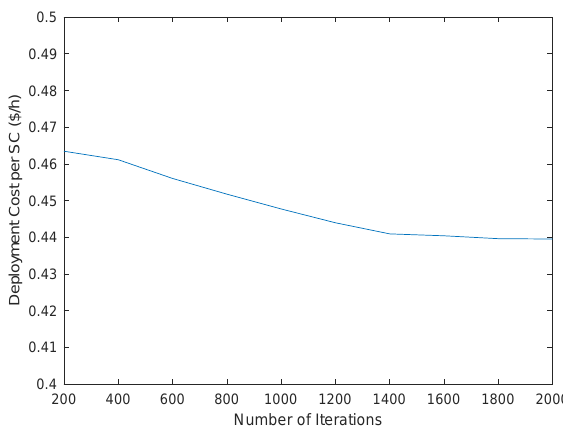
Figure 8. Impact of the Termination Criterion in Tabu Search.